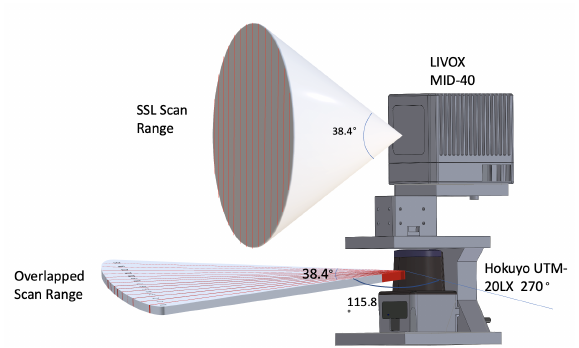
Figure 1. Physical layout of the mapping unit.